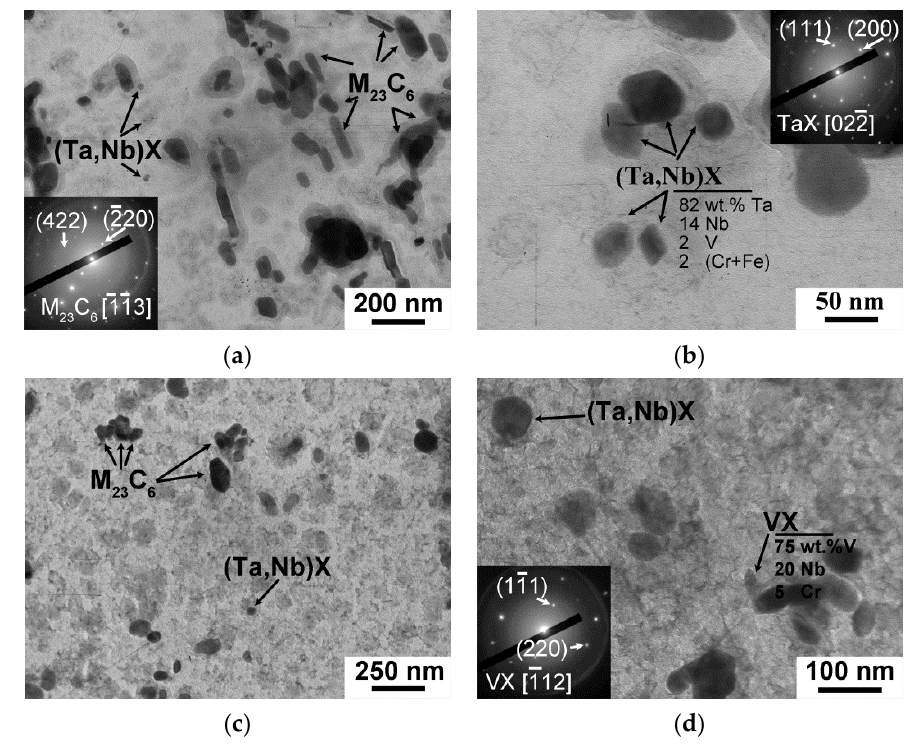
Figure 7. The secondary phase particles in the 12CrTaNb0.003N steel subjected to the CHT ( a , b ) and TMP ( c , d ) obtained using TEM of carbon